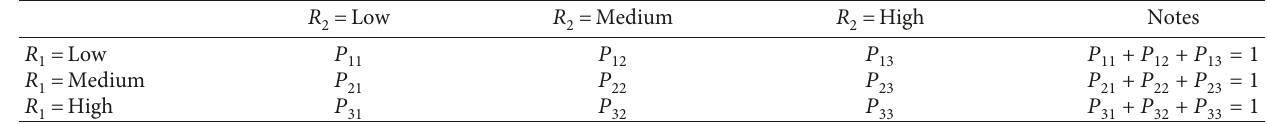
Table 1: Joint probability distribution column of risk sources R1 and